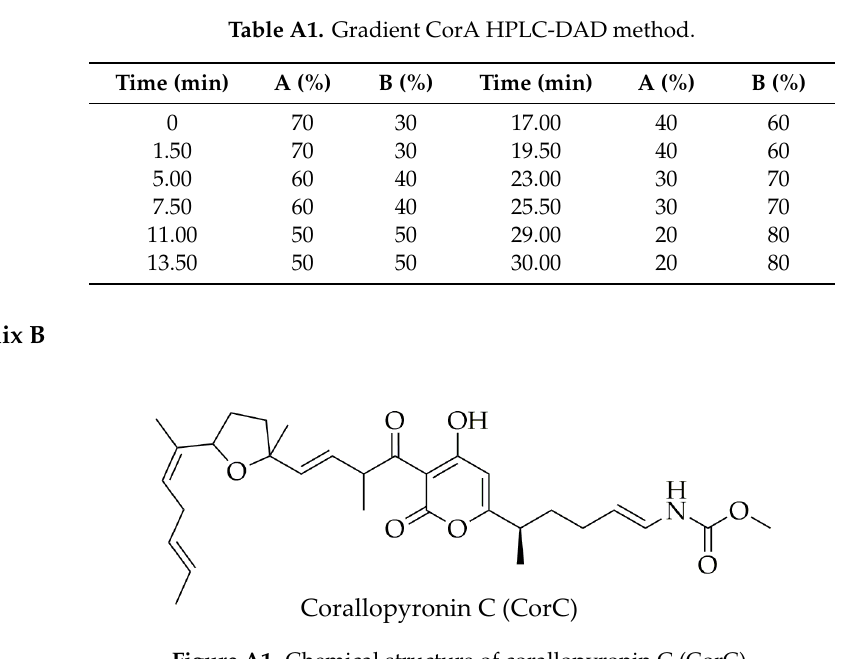
Figure A1. Chemical structure of corallopyronin C